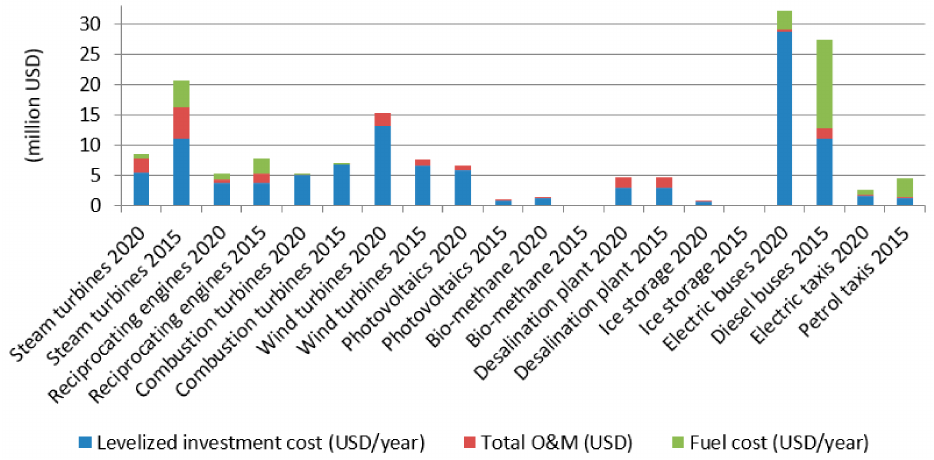
Figure 4. Economic results (carbon costs excluded) of the energy systems in the reference year and